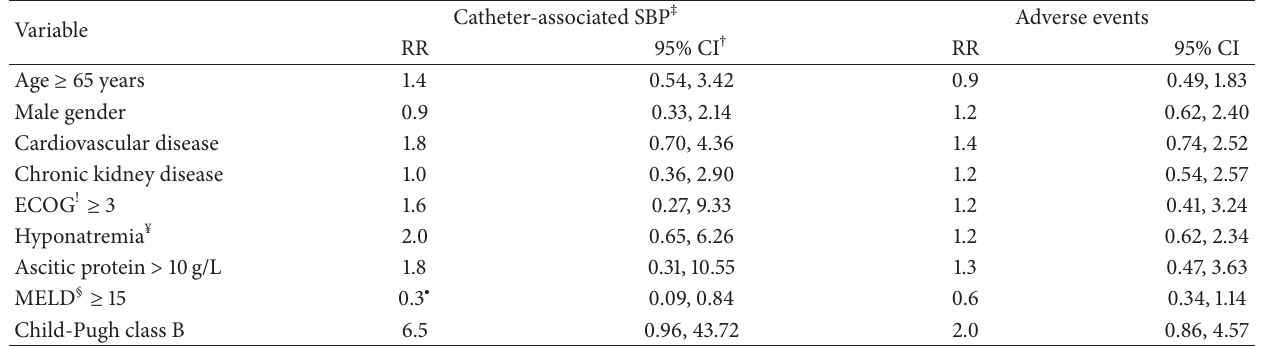
Table 3: Relative risks (RR) for variables related to catheter-associated SBP and adverse events i .